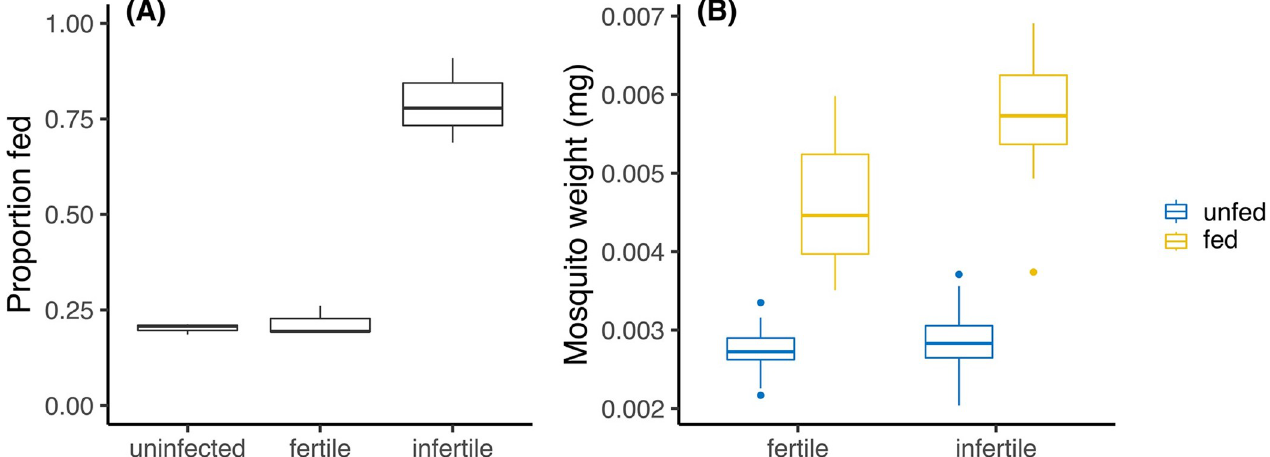
Fig 5. Boxplots of (A) female proportion that blood fed three days after they had been fully fed, in which three replicates were completed with 20–30 individual females for each replicate; and (B) the weights of fed and unfed females. 20 females that had fully fed and 20 that had not been provided with a blood meal from all three replicates were weighed at